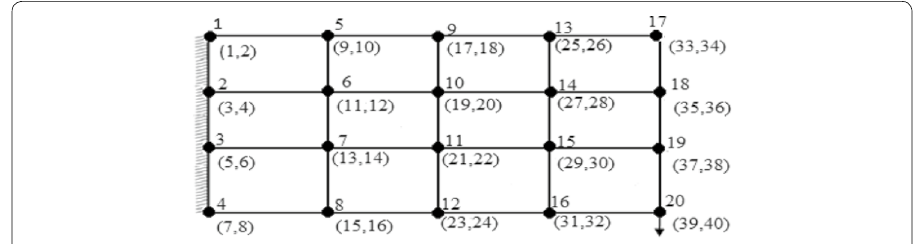
Fig. 3 Discretized design domain